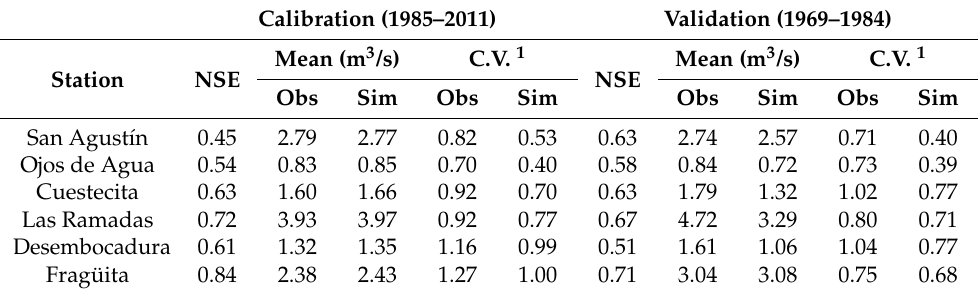
Table 2. Comparison of observed (obs) and simulated (sim) streamflows for calibration and validation